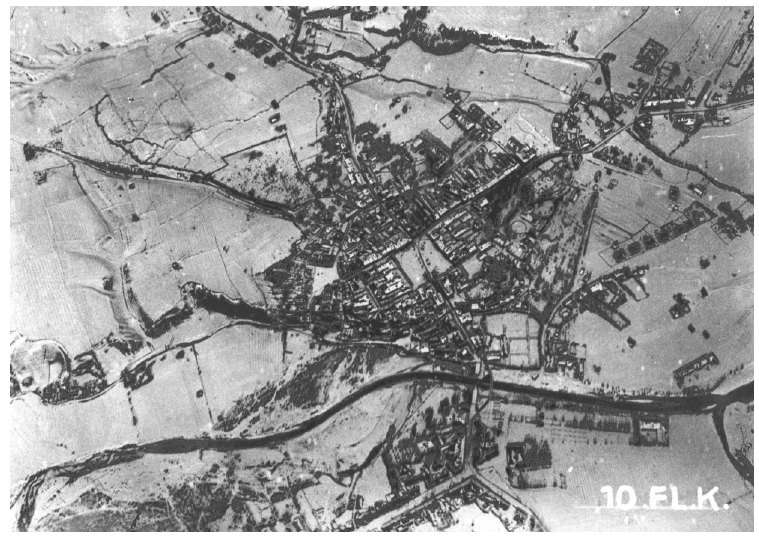
Fig. 3. Gorlice, 5 th February 1915, 10 FL.K. Source: Kriegsarchiv – Österreichisches Staatsarchiv [in:] Olędzki,